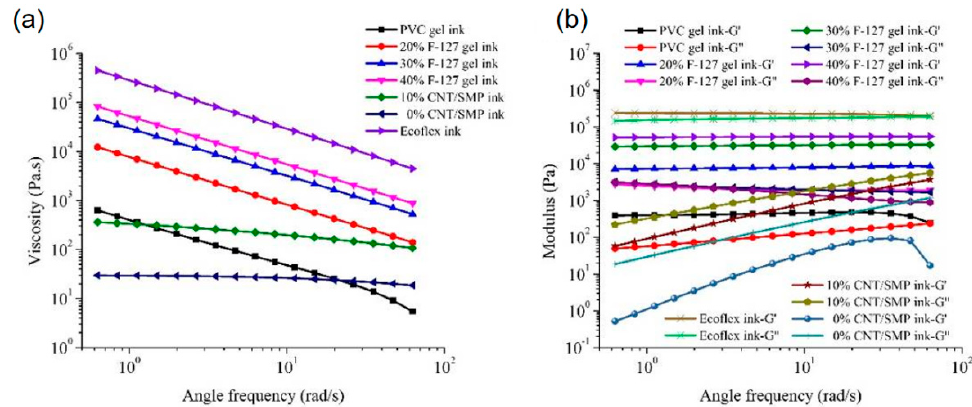
Figure 3. Preparation and performance characterization of the inks. ( a ) Viscosity and ( b ) moduli (storage modulus G’ and loss modulus G’’) of the PVC gel ink, F-127 gel ink with different concentrations, pure SMP ink, CNT/SMP ink, and Ecoflex ink as a function of the angular frequency.